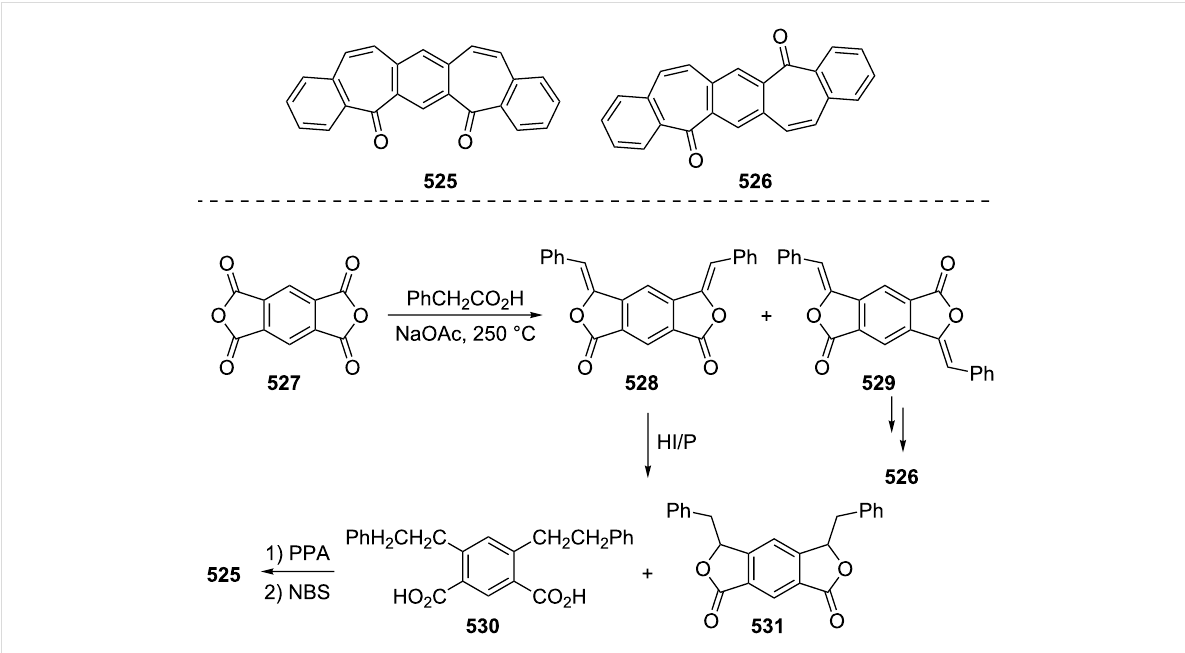
Scheme 95: Synthesis of benzoditropones 525 and 526 from pyromellitic dianhydride ( 527 ).